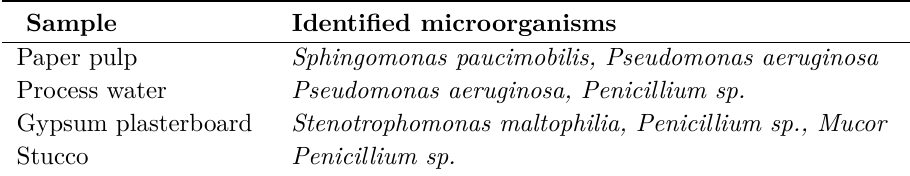
Table 1. Identification of the samples used to determine the resistance of the